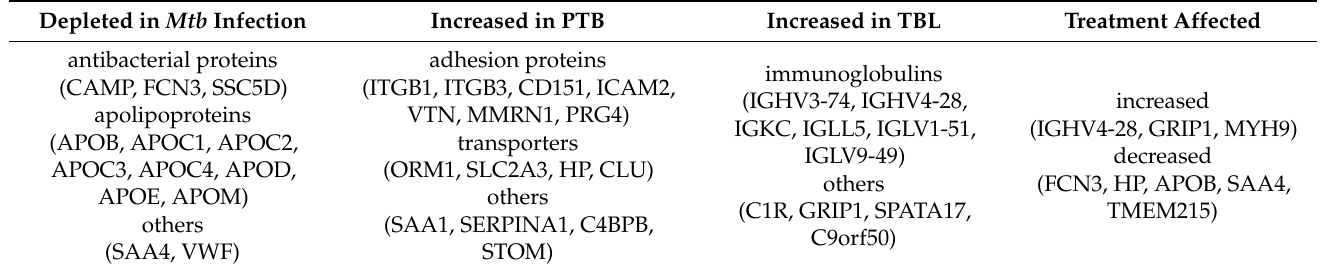
Table 2. Summary of disease state and treatment-specific protein contents of circulating exosomes. Proteins identified as differentially abundant proteins (DAP) in ANOVA and pairwise analyses were grouped by specificity to disease state or anti-TB treatment effect. Functional grouping was implemented according to manual literature